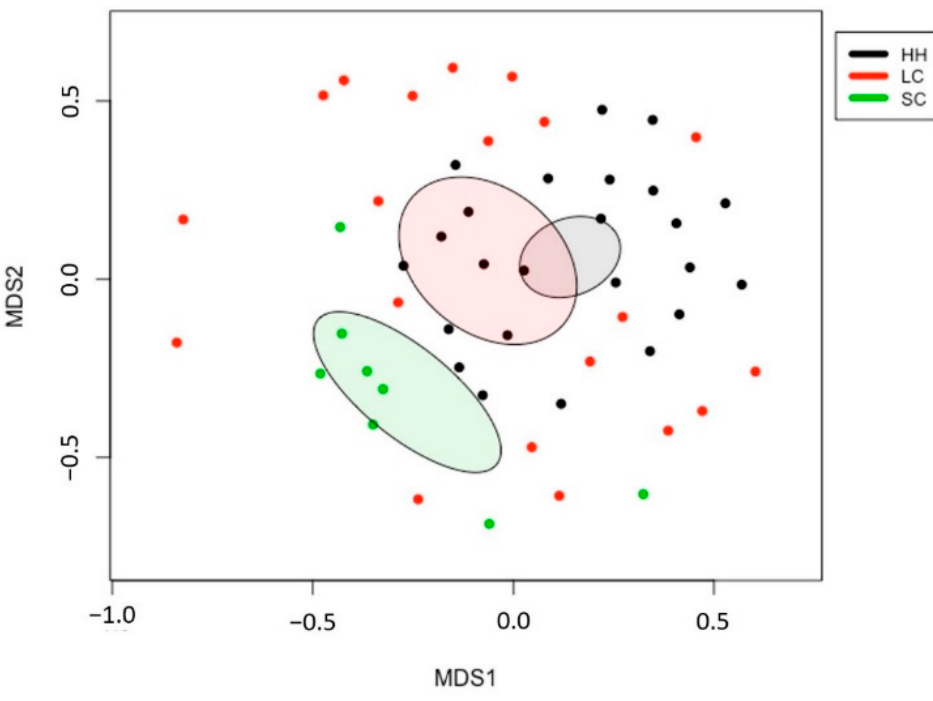
Figure 2. Nonmetric multidimensional scaling (NMDS) analysis for a beta-diversity comparison of the horse fecal microbiota. HH, healthy horses; LC, horses with large intestinal colic; SC, horses with small intestinal colic.